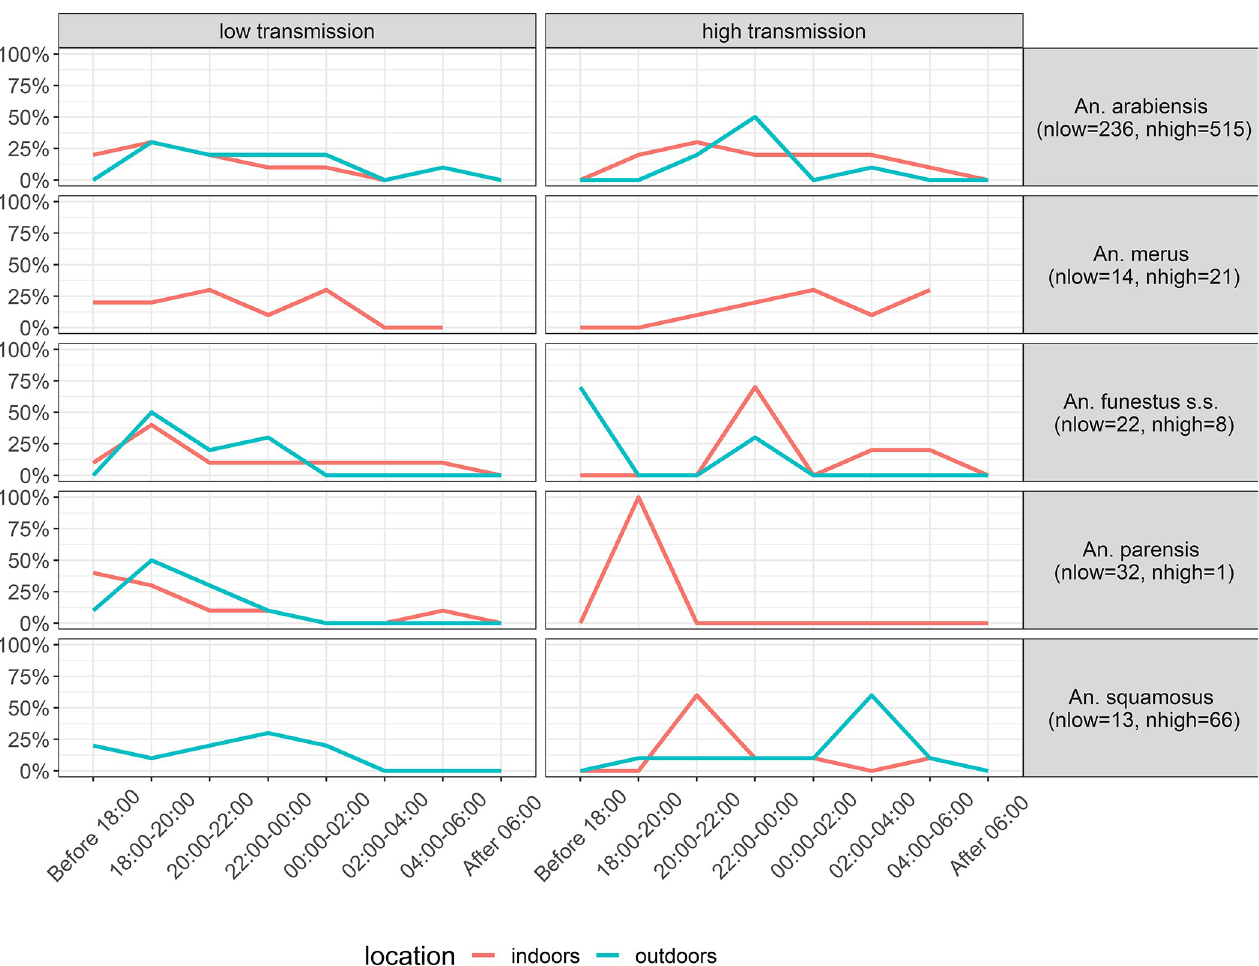
Fig 3. Host-seeking behavior of five different malaria vector species in Magude district between 4pm and 8am. The proportion of host-seeking mosquitoes collected indoors and outdoors is shown in 2 hour intervals.